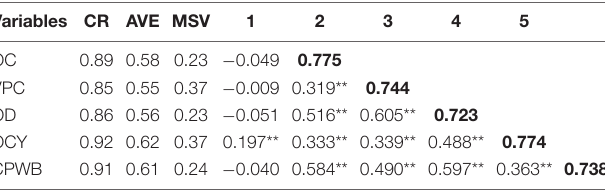
TABLE 1 | Reliability, validity, and correlation analysis.